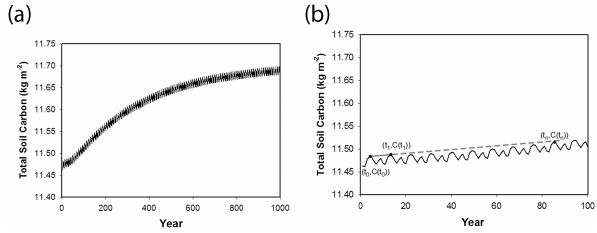
Figure 2. Annual average total soil carbon change with respect to time (a) and the gradient projection over a shorter time interval (b)